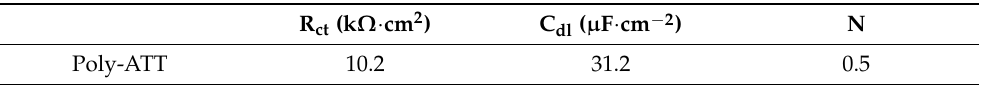
Table 3. Electrochemical parameters obtained by the SIE of the interface 60Cu-40Zn/ poly-ATT in a medium 0.1 M KOH + CH 3 OH.